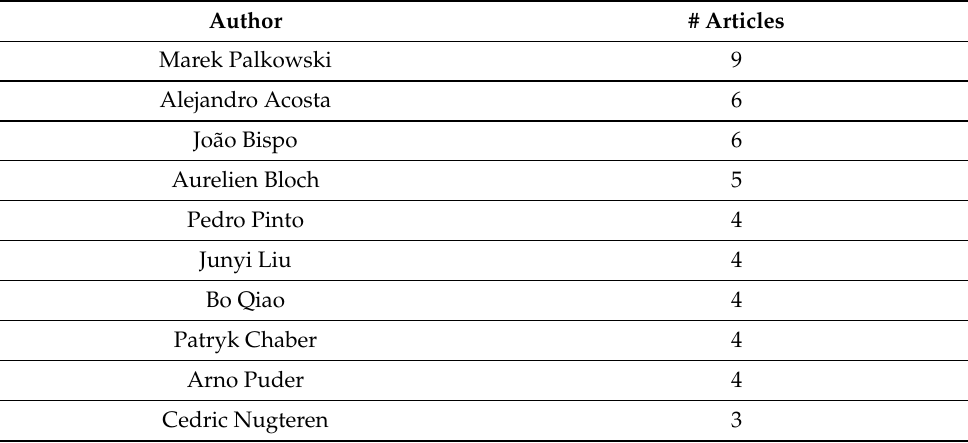
Table 10. Top 10 most-recurrent authors (first author).